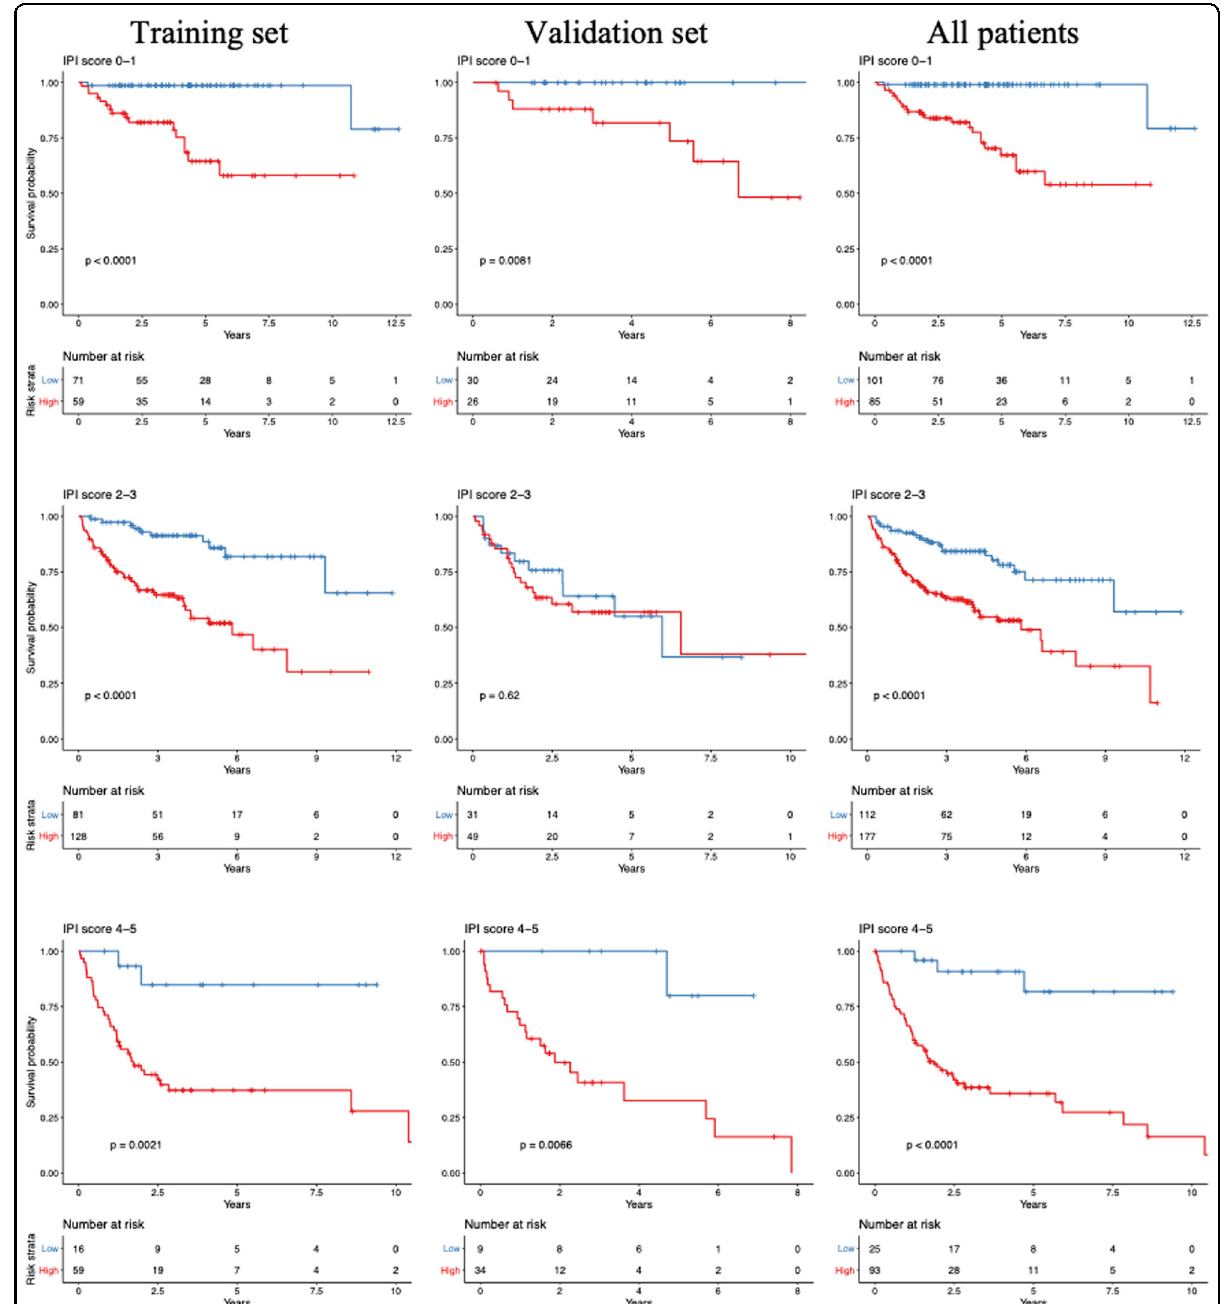
Fig. 5 Overall Survival Strati fi ed by IPI Risk Groups. The overall survival among patients in the various IPI risk groups in the training, test, and entire datasets, strati fi ed according to the optimal cut-off for the gene expression-based survival-predictor